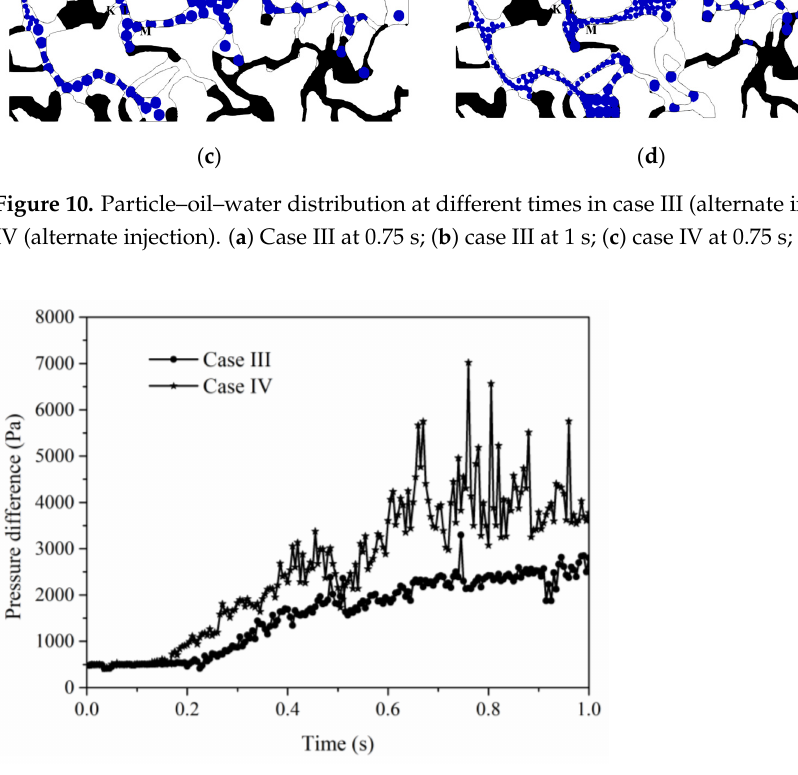
Figure 11. Variation of inlet–outlet pressure difference with time in case III (alternate injection) and case IV (alternate